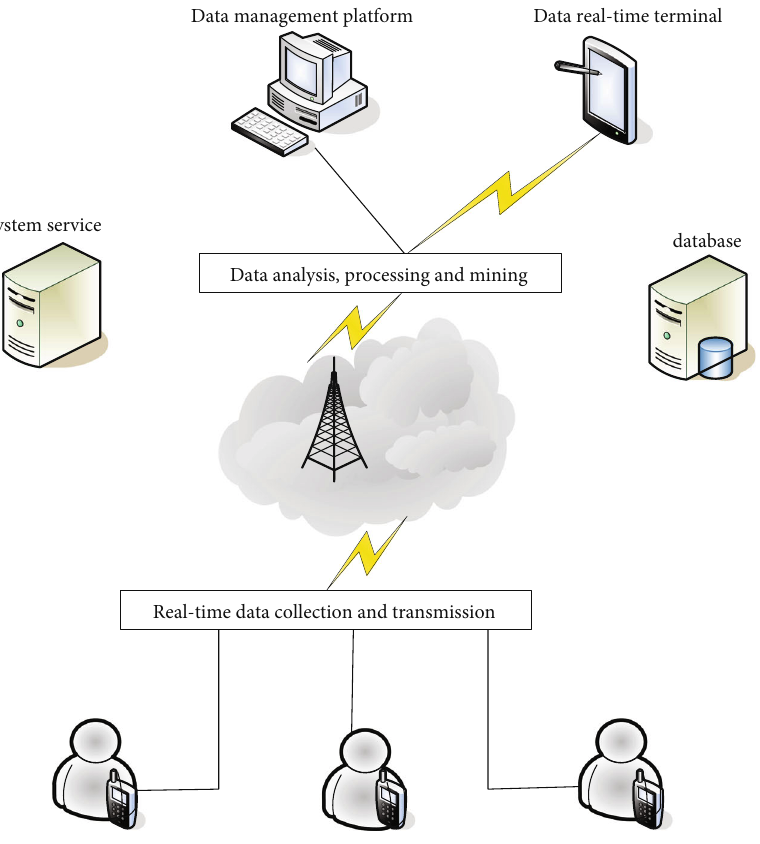
Figure 1: Real-time monitoring system